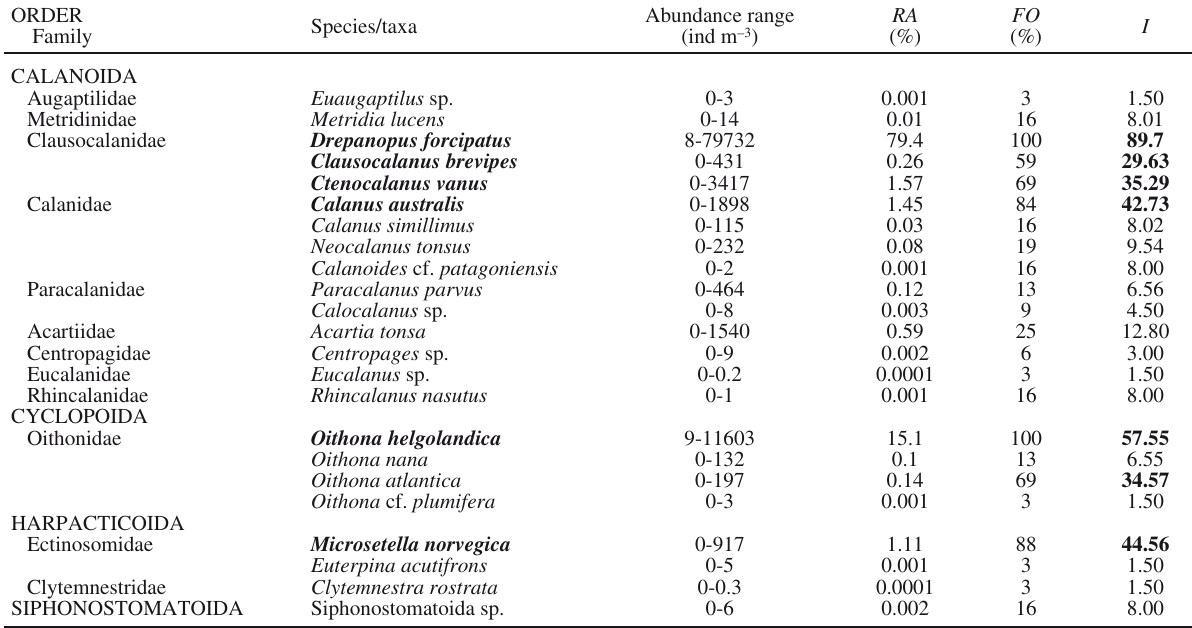
Table 1. – List of copepod species/taxa collected with a 66-µm mesh net (small Bongo sampler) over the southern Patagonian shelf in March/ April 2004. Taxonomic classification after Boxshall and Halsey (2004). RA , relative abundance; FO , frequency of occurrence; I , index of importance (average between RA and FO ). Important or dominant species are in bold ( I ≥ 20%). ORDER Species/taxa Family CALANOIDA